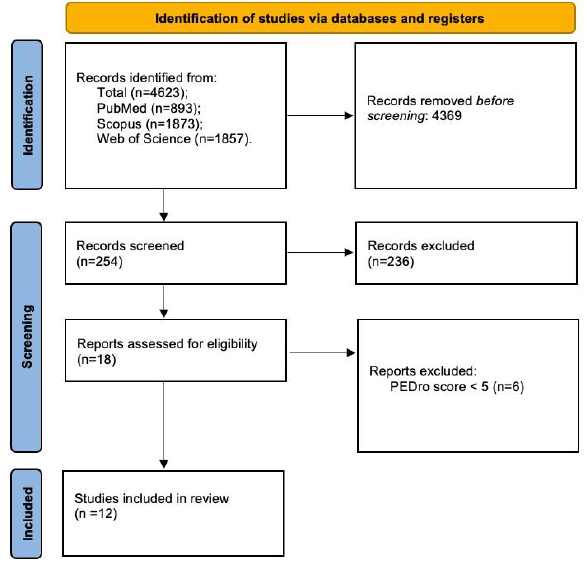
Figure 2. PRISMA flow diagram for Systematic Review. Table 1. Studies quality assessment (PEDro Scale).